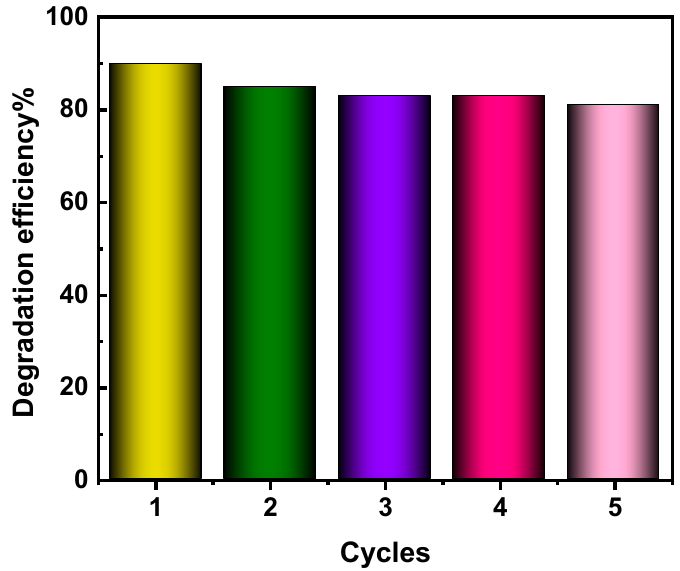
Figure 10. Recycling of 7.5% of nanostructured Nd 2 O 3 doped CuO.